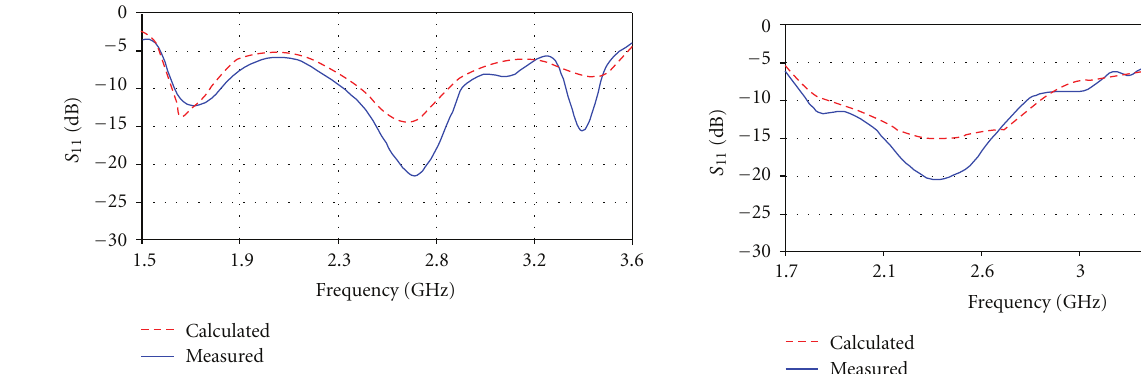
Figure 8: Calculated and measured return loss of the high-band antenna of the third configuration.